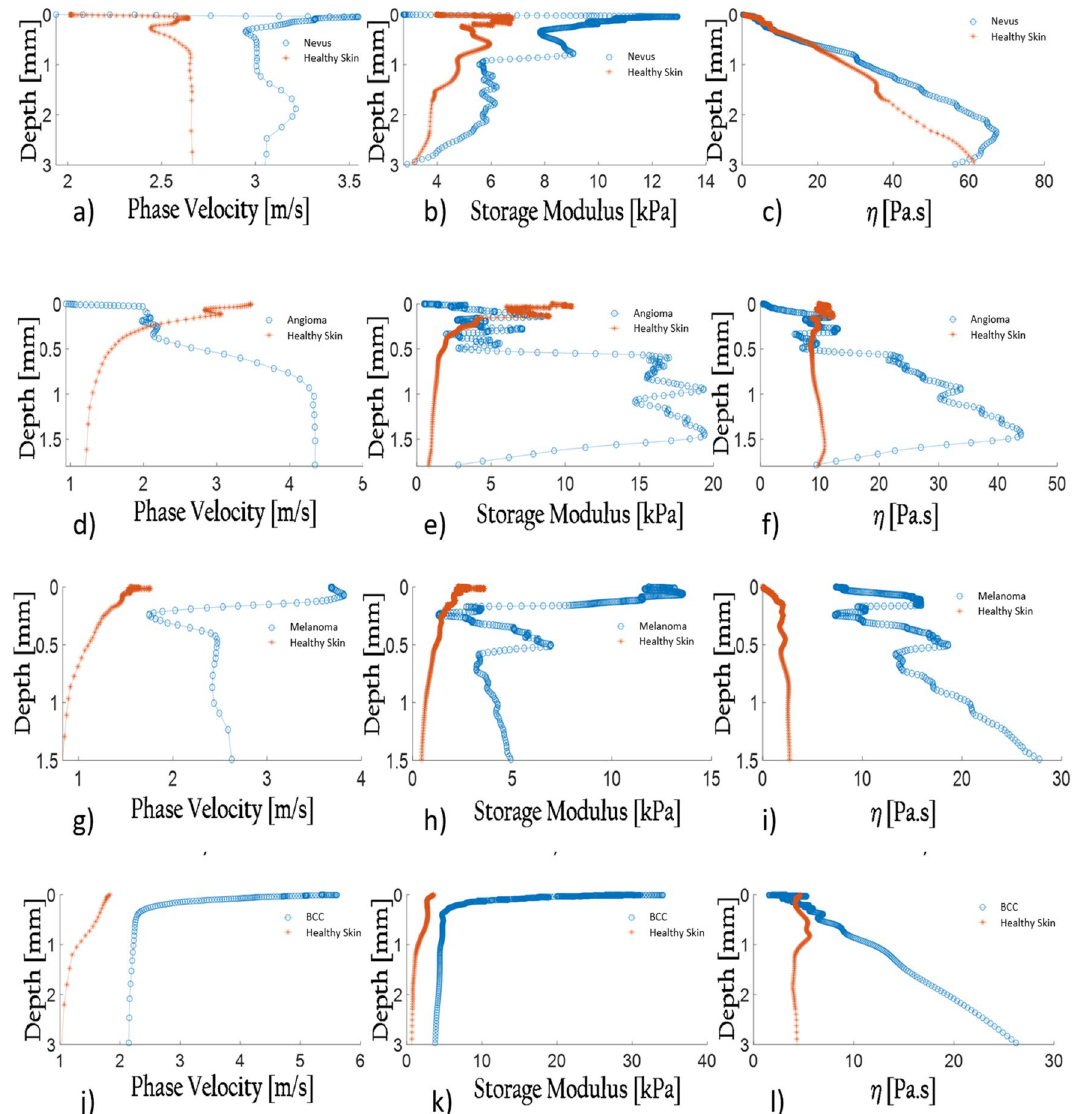
Figure 3. ( a ) Angioma velocity profile in comparison with adjoing skin velocity profile. ( b ) Angioma storage modulus profile in comparison with adjoing skin storage modulus profile. ( c ) Angioma viscosity parameter profile in comparison with adjoing skin viscosity parameter profile. ( d ) Melanoma velocity profile in comparison with adjoing skin velocity profile. ( e ) Melanoma storage modulus profile in comparison with adjoing skin storage modulus profile. ( f ) Melanoma viscosity parameter profile in comparison with adjoing skin viscosity parameter profile. ( g ) BCC velocity profile in comparison with adjoing skin velocity profile. ( h ) BCC storage modulus profile in comparison with adjoing skin storage modulus profile. ( i ) BCC viscosity parameter profile in comparison with adjoing skin viscosity parameter profile. ( j ) Papillometous nevus velocity profile in comparison with adjoing skin velocity profile. ( k ) Papillometous nevus storage modulus profile in comparison with adjoing skin storage modulus profile. ( l ) Papillometous nevus viscosity parameter profile in comparison with adjoing skin viscosity parameter